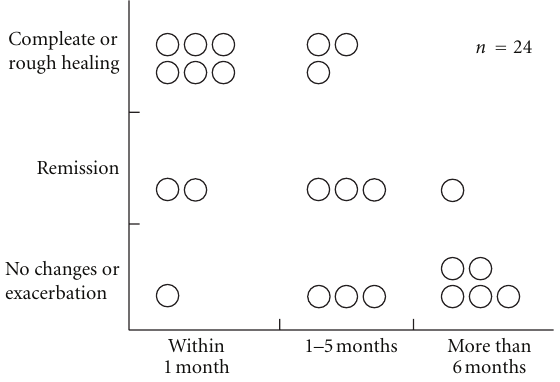
Figure 7: Prognosis depending on time of initiation of treatment [19].